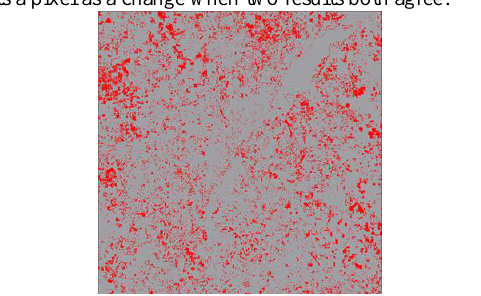
Figure 7. Change detection result of pixel-based method combined dNDVI with